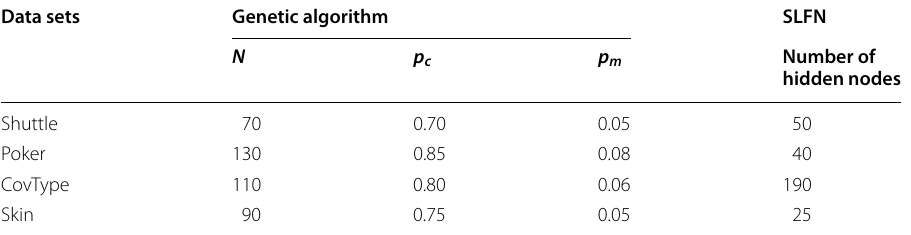
Table 6 The setting of parameters in genetic algorithm and in SLFN Data